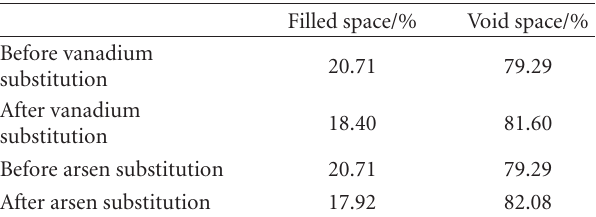
Table 6: Porosity of osteoporosis bone for vanadium and Arsen substitution.